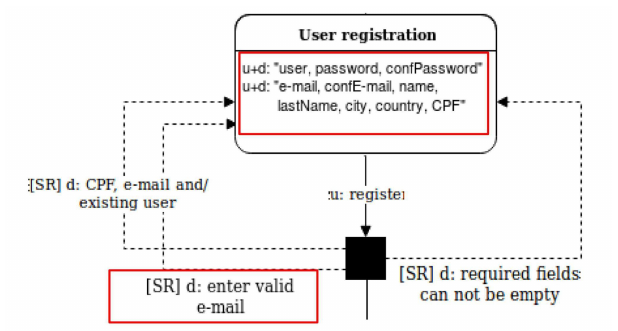
Figure 2. Diagram register user - defect strange information.